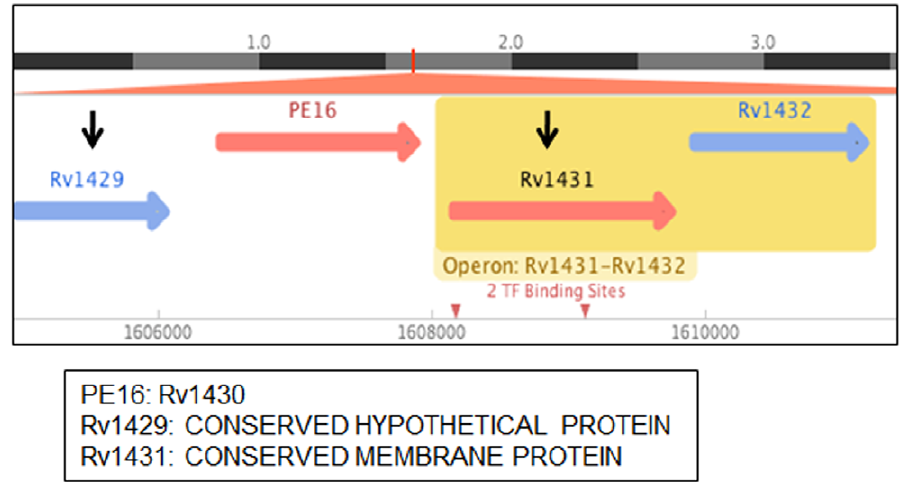
Figure 8. Genomic organization of Rv1430 (source: http://www.tbdb.org/and http://genolist.- pasteur.fr/TubercuList/).